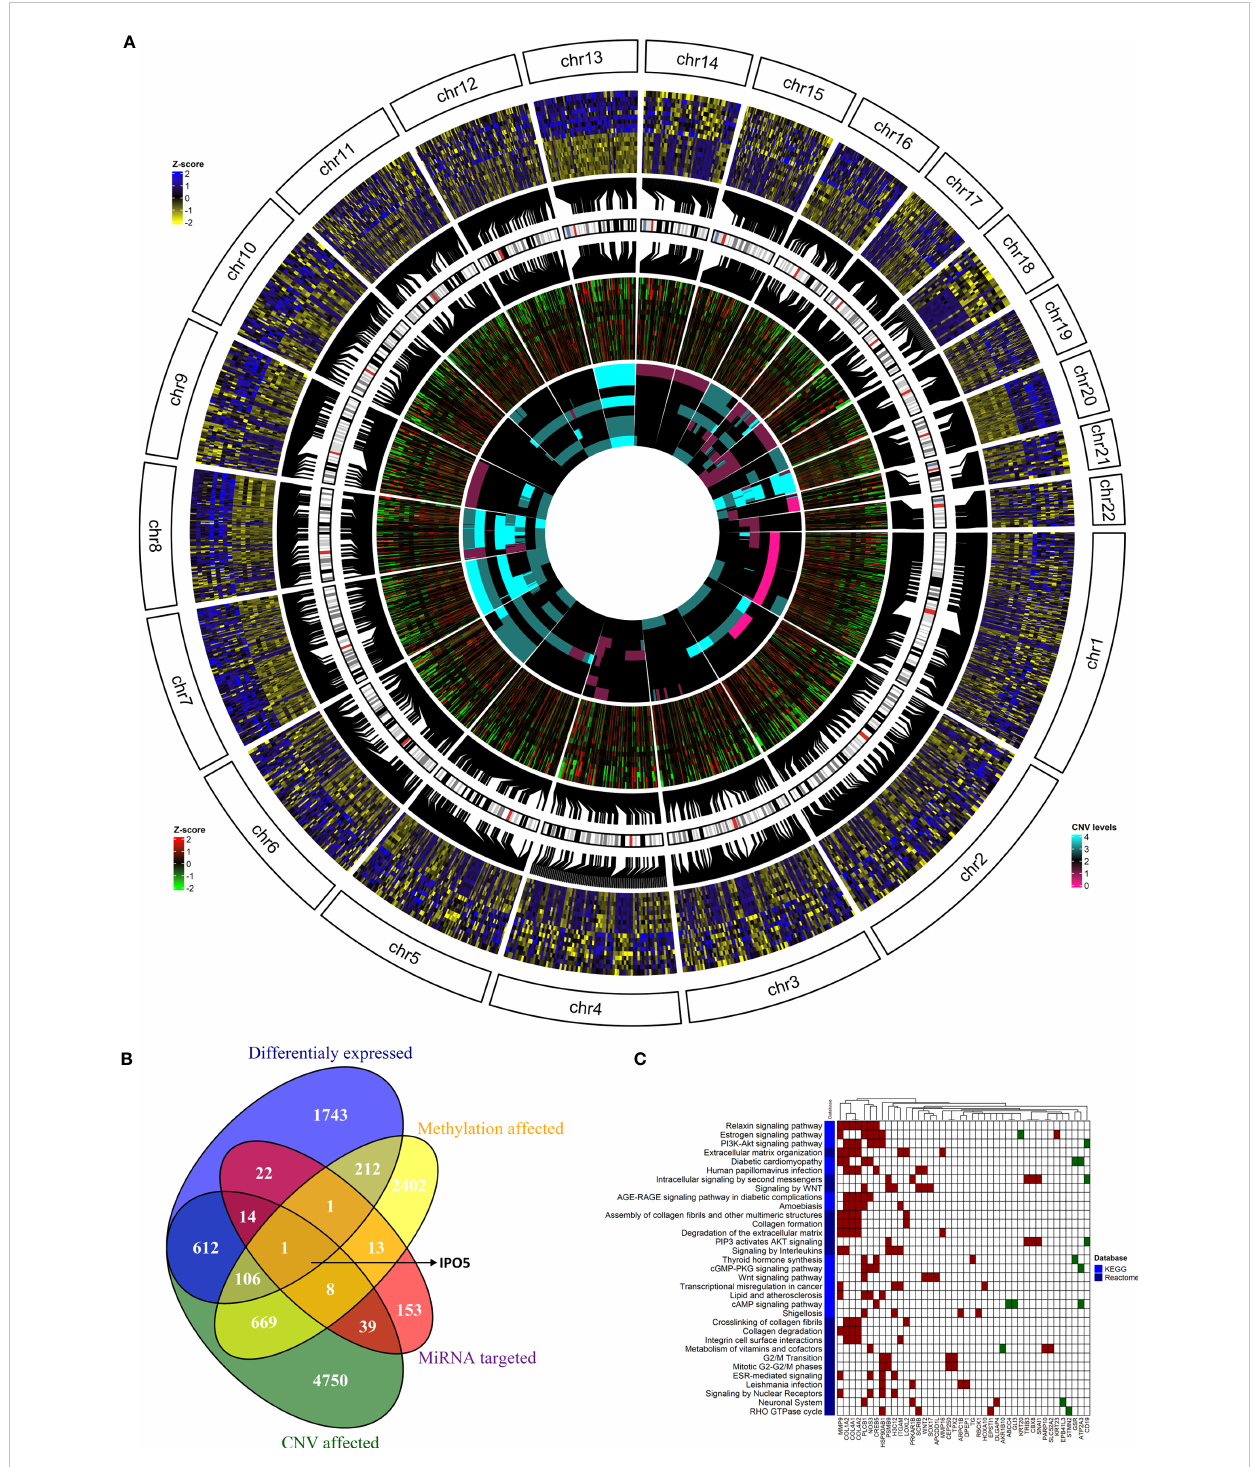
FIGURE 6 The integration of results from the genome, methylome, transcriptome, and miRNAome analyses. (A) The overlap of alterations discovered between the CRCLM patients across all platforms. The outside heatmap circle represents the signi fi cant DEGs, the blue color represents up-regulation, yellow color represents down-regulation. The middle heatmap circle represents the methylation level for the genes depicted in the outside circle, the red color represents hypermethylation, the green color hypomethylation, and the black color non-signi fi cant changes. The inner heatmap represents the CNV level for the genes depicted in the outside circle. The cyan color represents gains, the purple represents losses. (B) Venn diagram showing the overlap between DEGs obtained in the analysis strati fi ed by methylation pro fi le, CNV, and miRNA expression levels. (C) The heatmap of KEGG (light blue) and Reactome (dark blue) enriched pathways and genes from integrated analysis of genome, methylome and transcriptome analyses. Up-regulated genes have red square while down-regulated genes have green square. White square means that the gene is not present in the speci fi c